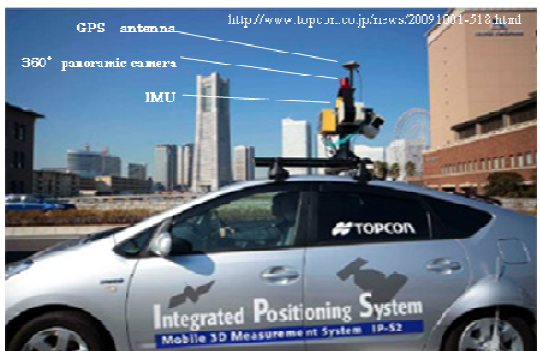
Figure 2. Outline of Mobile Mapping System (MMS)